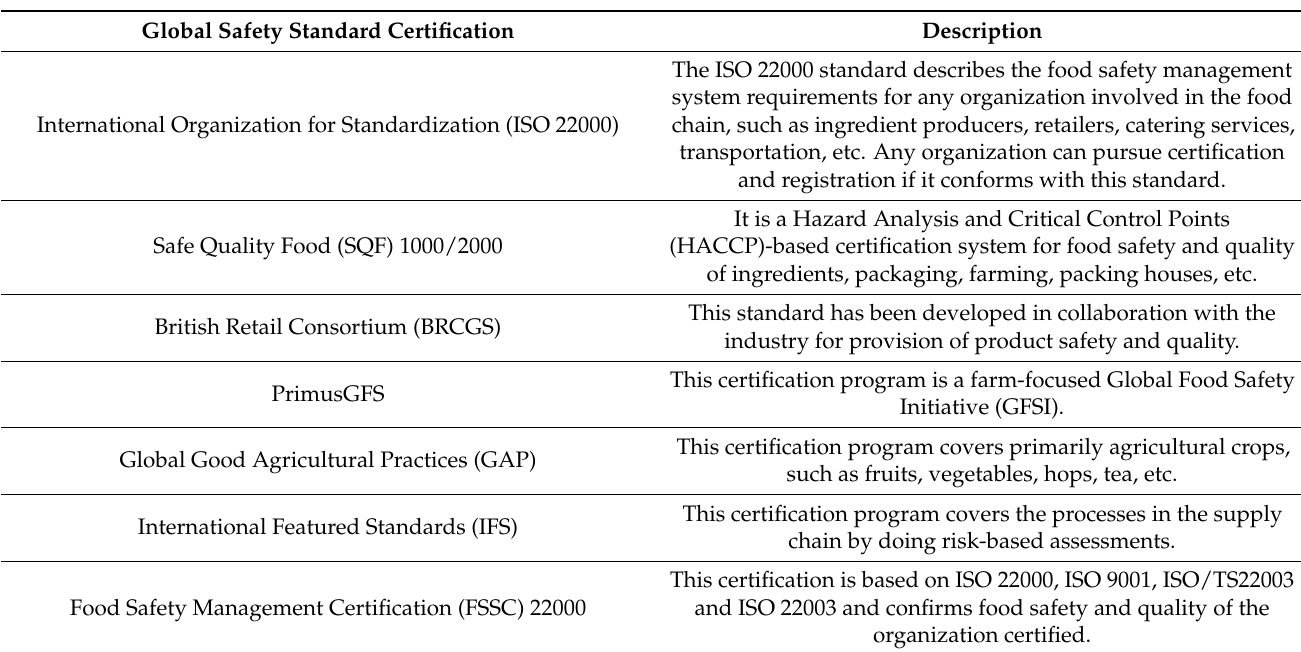
Table 4. Examples of private food safety standards for certification for food industries